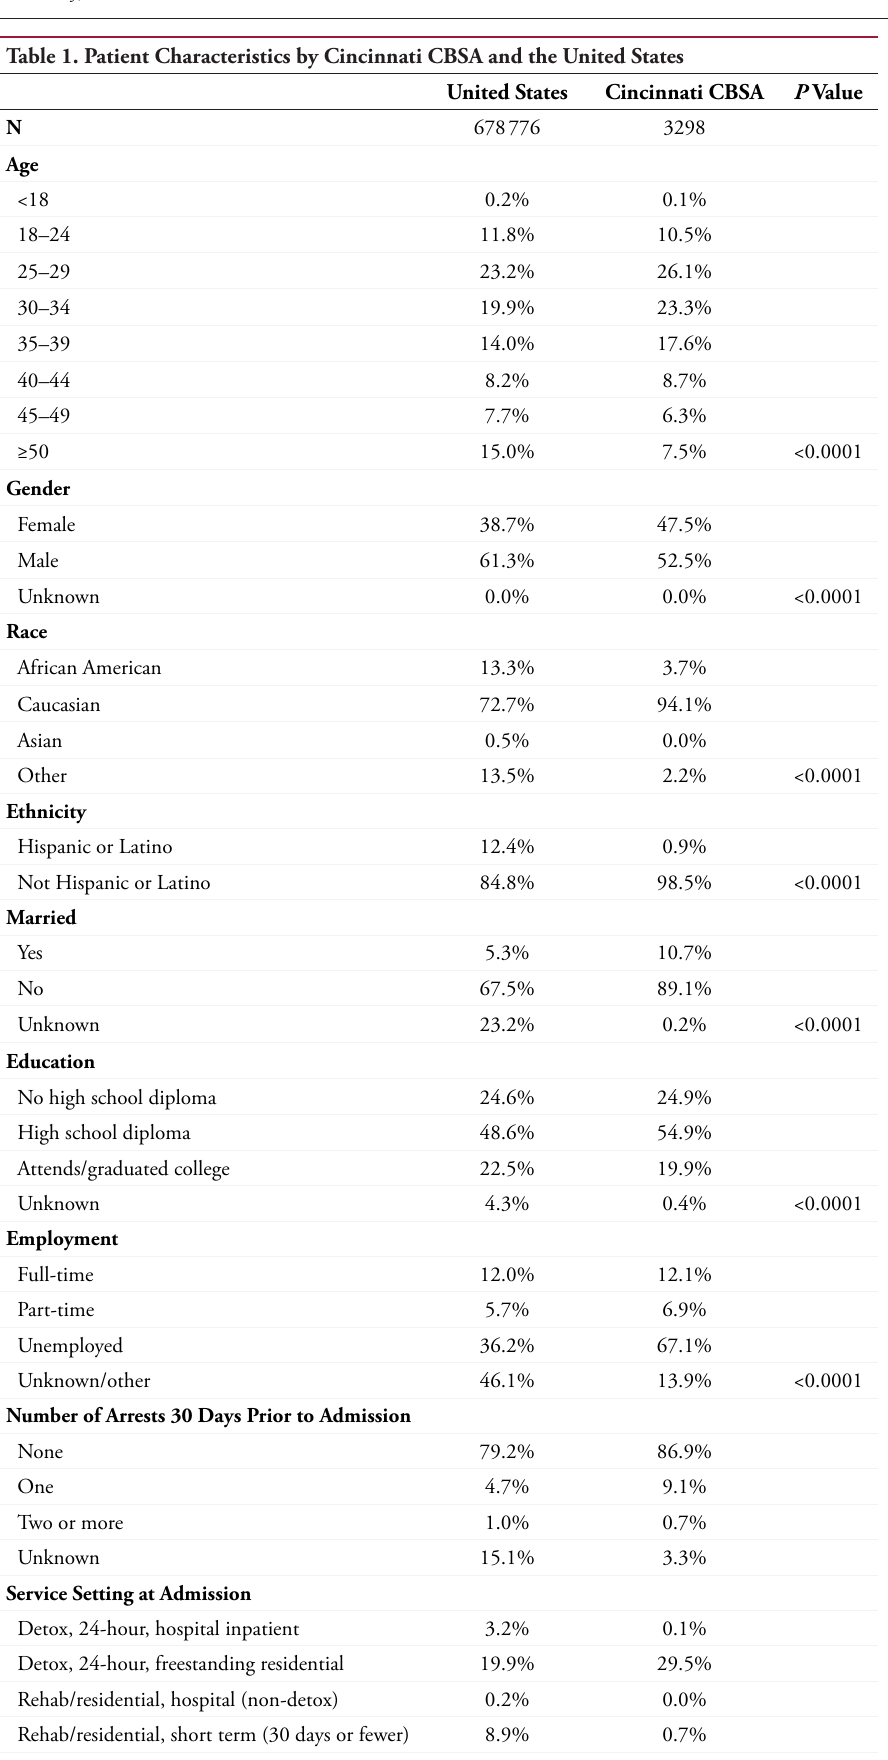
Table 1. Patient Characteristics by Cincinnati CBSA and the United States